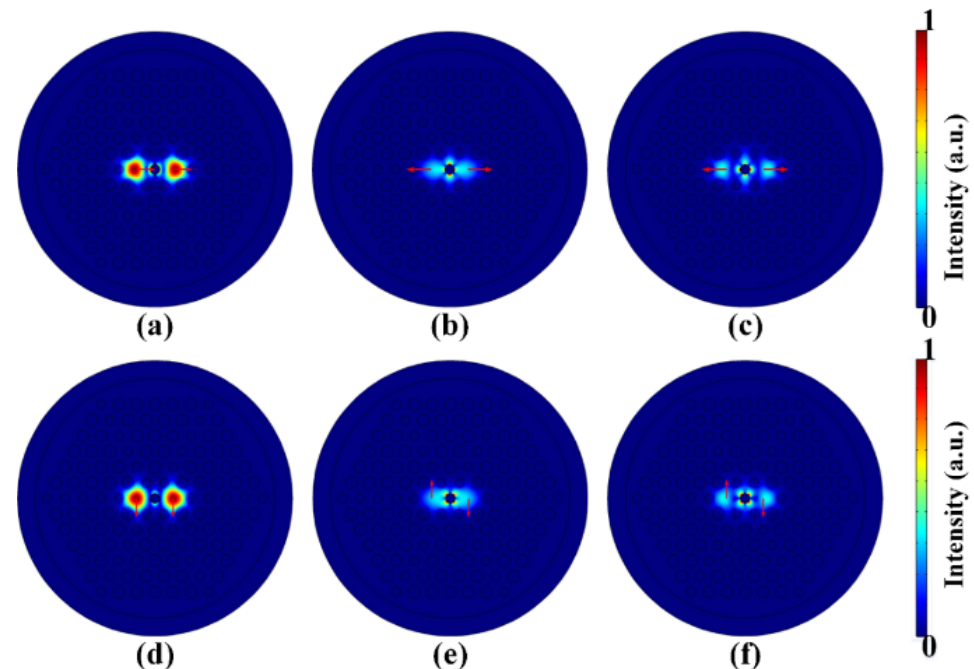
Figure 2. The mode fields of ( a ) the X -pol even mode, ( b ) X -pol odd mode, and ( c ) X -pol second SPR mode at the wavelength of 1.239 µ m. The mode-field distribution of ( d ) the Y-pol even mode,